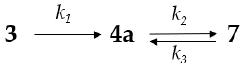
Figure 5. Interconversion kinetics for compounds 3 , 4a, and 7; each compound is represented by a fitted curve based on integral values of its two imidazole signals. Scheme 3 . Consecutive degradation of reactant 3 to the two products, 4a and 7 ; k 1 , k 2 , k 3 presents reaction rate constants.